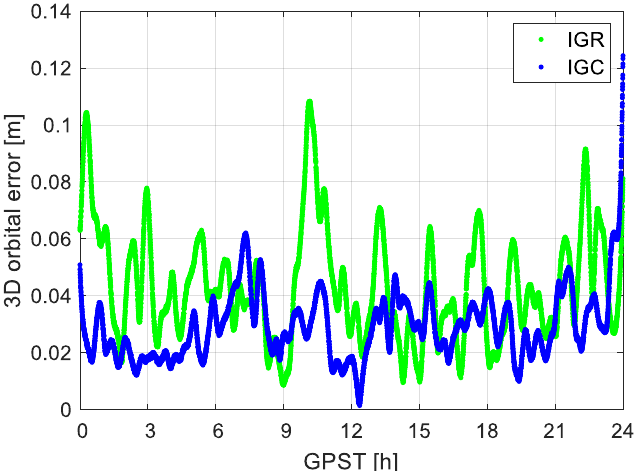
Figure 8. 3D orbital errors of the phase-based reduced-dynamic orbits using data of GRACE FO-1 with a 100% duty-cycle, a mean satellite number of 9, and a sampling interval of 10 s (having the IGS final as the reference). Different IGS products were applied.